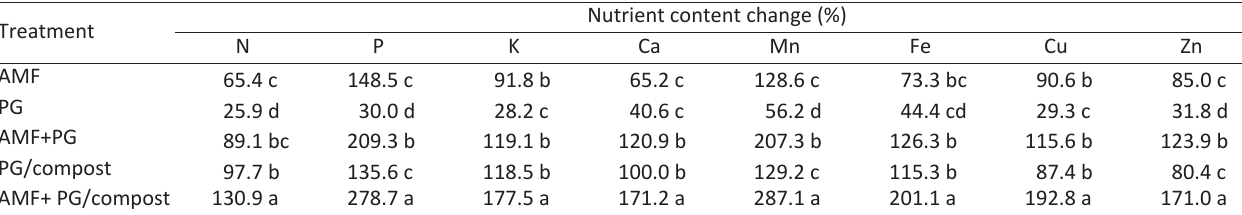
Table 5 - Percentage change in nutrient contents (NC) due to PG amendment and AMF inoculation of cotton plants